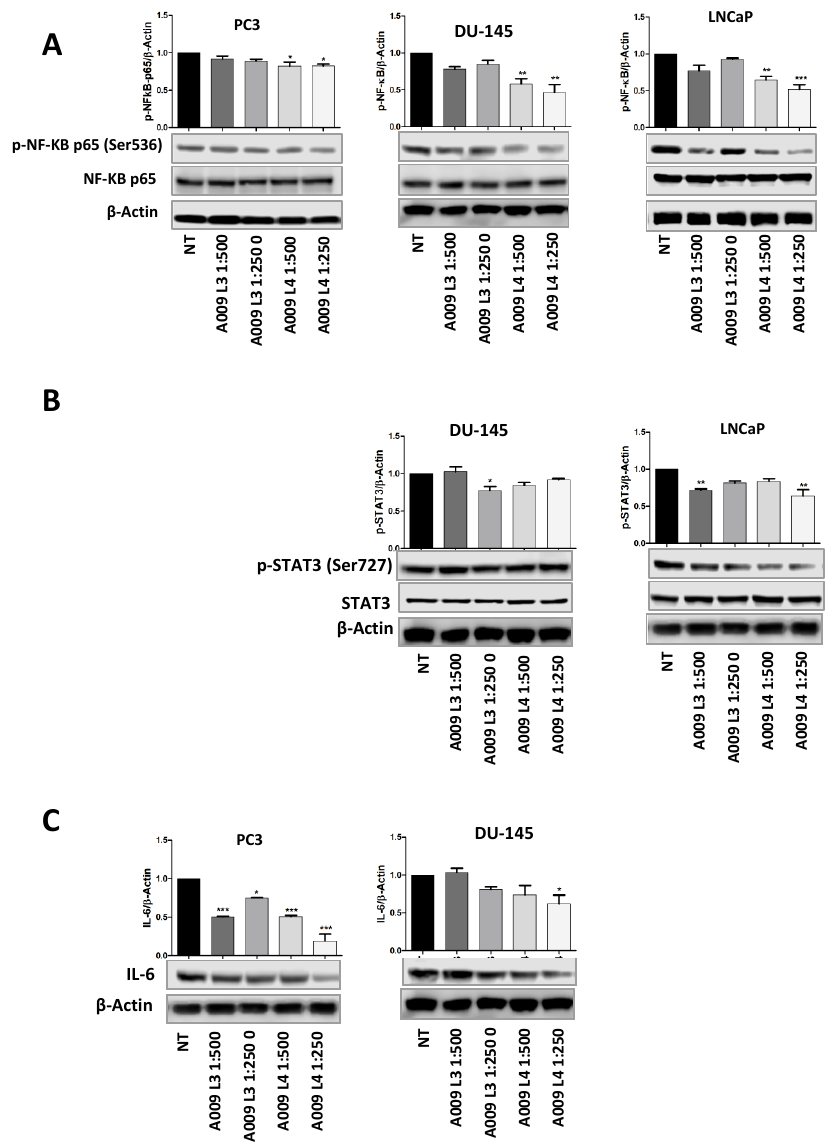
Figure 5. Effects of A009 on NF- κ B, IL-6, and STAT3 production and activation in human prostate cancer cells. PC-3, DU-145, and LNCaP cells were treated for 24 h with A009 (L3 and L4, dilution 1:250, 1:500). ( A ) Effects of A009 (L3 and L4, dilution 1:250, 1:500) on phosphorylation of NF- κ B (Ser536) were determined by Western blot. A009 was able to significantly lower activation of NF- κ B in PCa cell lines. ( B ) A009 affects activation of p-STAT3 (Ser727) on DU-145 and LNCaP, and ( C ) downregulates IL-6 in PC-3 and DU-145 when treated with A009. Results are showed as mean ± SEM, ANOVA, * p < 0.05, ** p < 0.01.